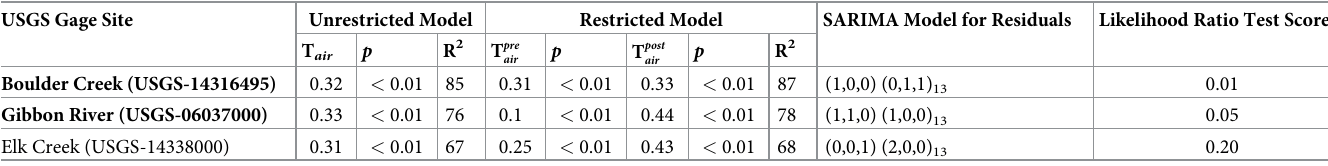
Table 5. Coefficients and fitness of restricted and unrestricted regression models for pre- and post-fire weekly summer air temperature—water temperature rela- tions for studied stream sites. Sites in bold are those where the restricted regression model was significantly ( p < 0.05) different from the unrestricted regression model.